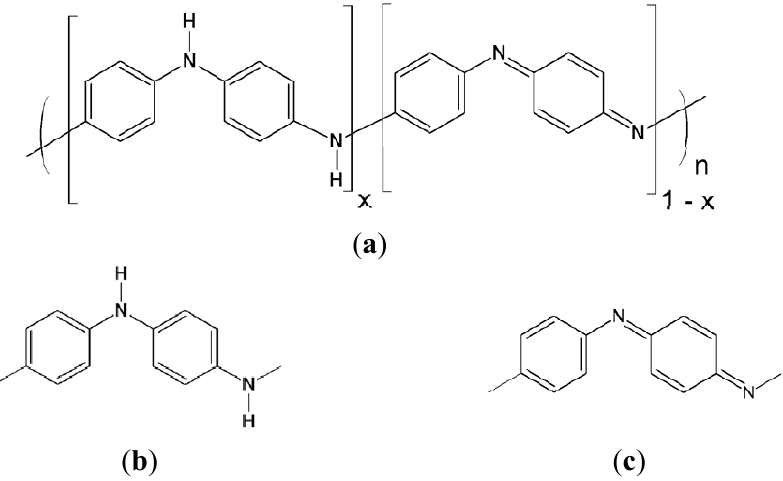
Figure 1. A general chemical structure of polyaniline and its repeating units. ( a ) A general chemical structure of polyaniline, ( b ) Reduced repeating unit, and ( c ) oxidized repeating unit.